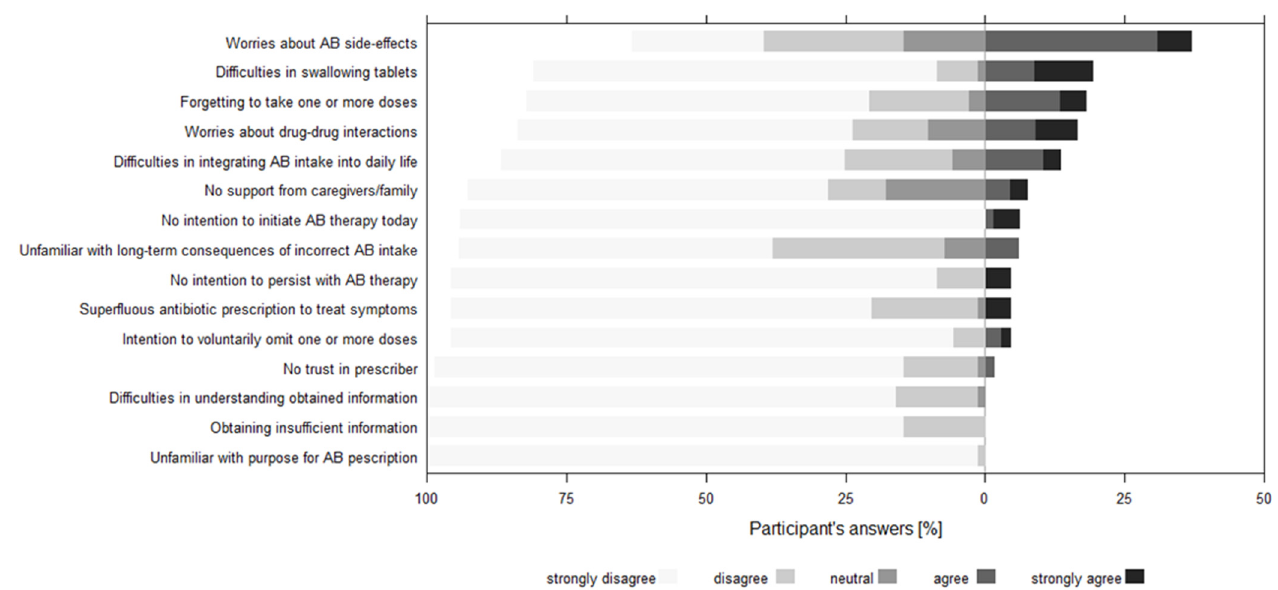
Figure 1. Frequencies of the answers to 15 medication adherence barriers to ABs, rated on a 5-point Likert-agreement scale (from strongly disagree to strongly agree) by 68 participants (67 for 4 items, respectively) sorted by descending order of agreement. The zero line represents the threshold between agreement and disagreement. Table 2. Medication adherence estimates from the patients participating in the construct validation study ( n = 68). Patients with a once-daily regimen ( n = 2) were excluded from the sub-analysis. For estimates calculated, see statistical analysis in Section